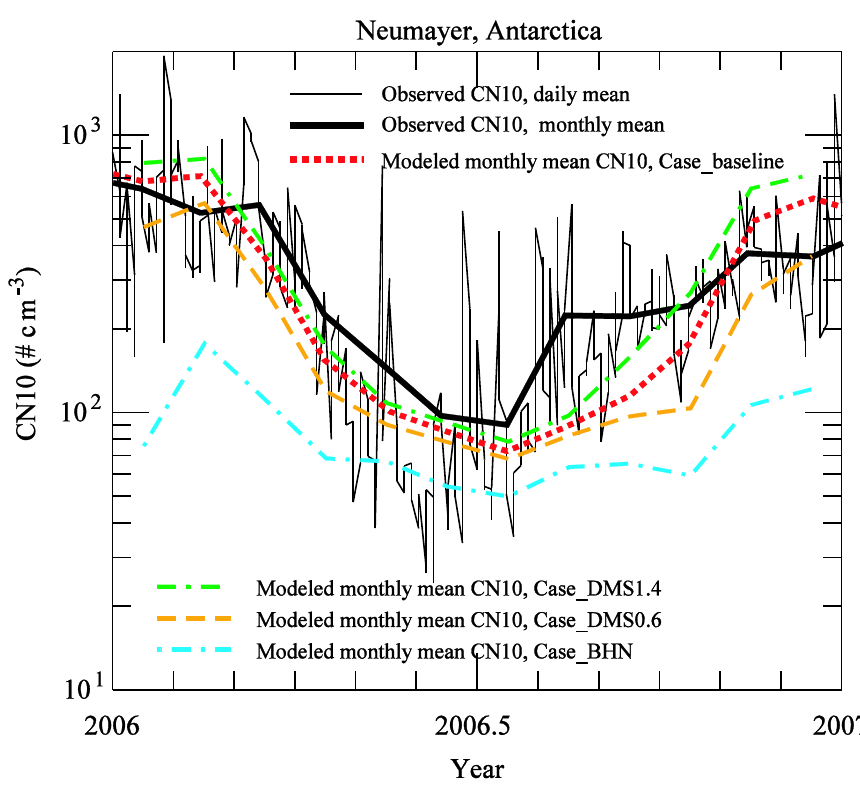
Figure 5. Observed and simulated CN10 values in different months of 2006 at the Neumayer station. See text for